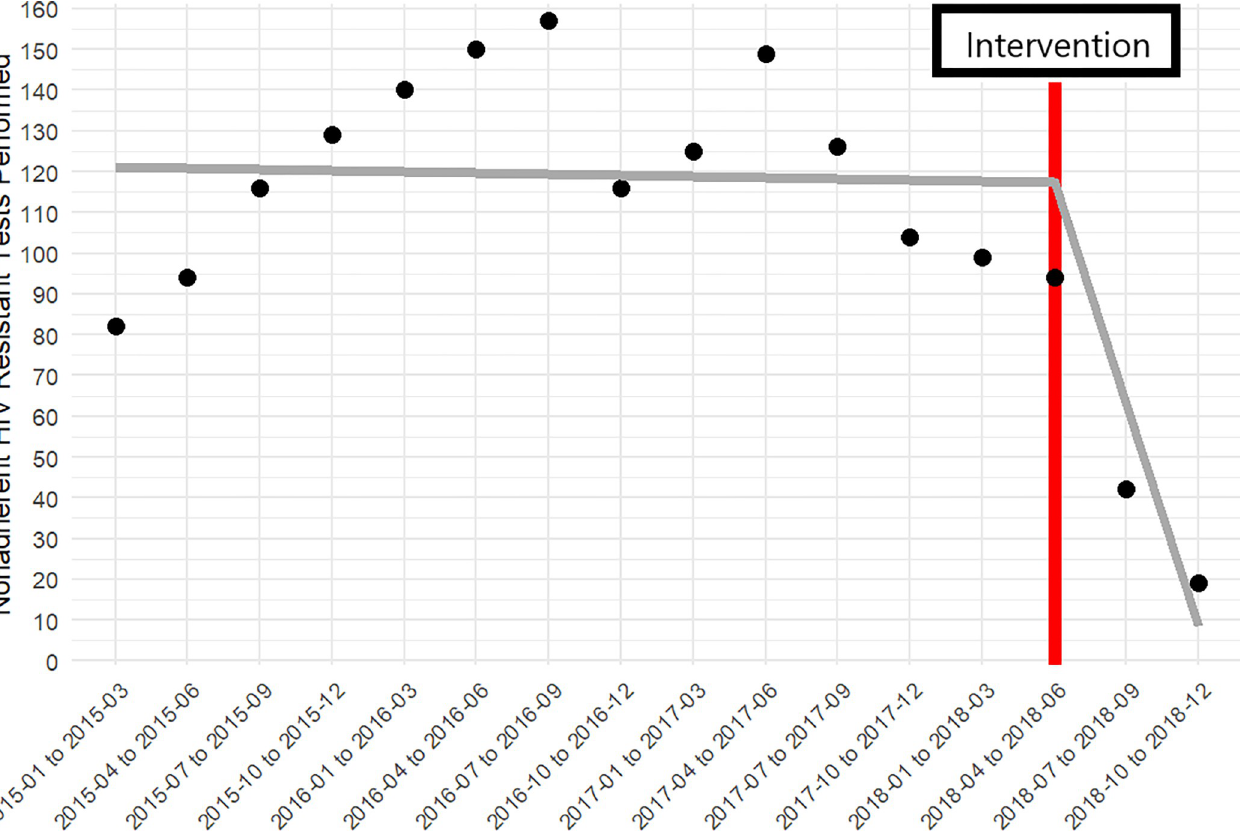
Fig 3. Reduction of inappropriate HIV resistance tests performed at outlier facilities before and after an intervention (i.e., phone calls). Total tests performed at outlier facilities before and after an intervention (gray; continuous piecewise linear spline). The red vertical line represents the timing of the